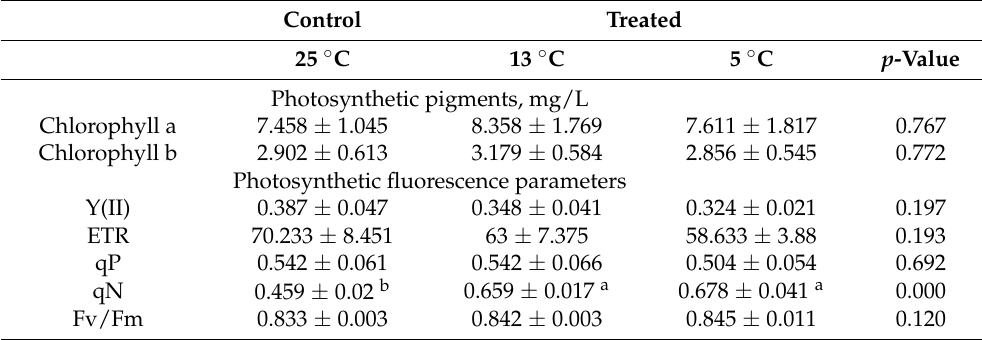
Table 1. Effect of upwelling on chlorophyll contents and fluorescence parameters in the leaves of K. obovata .